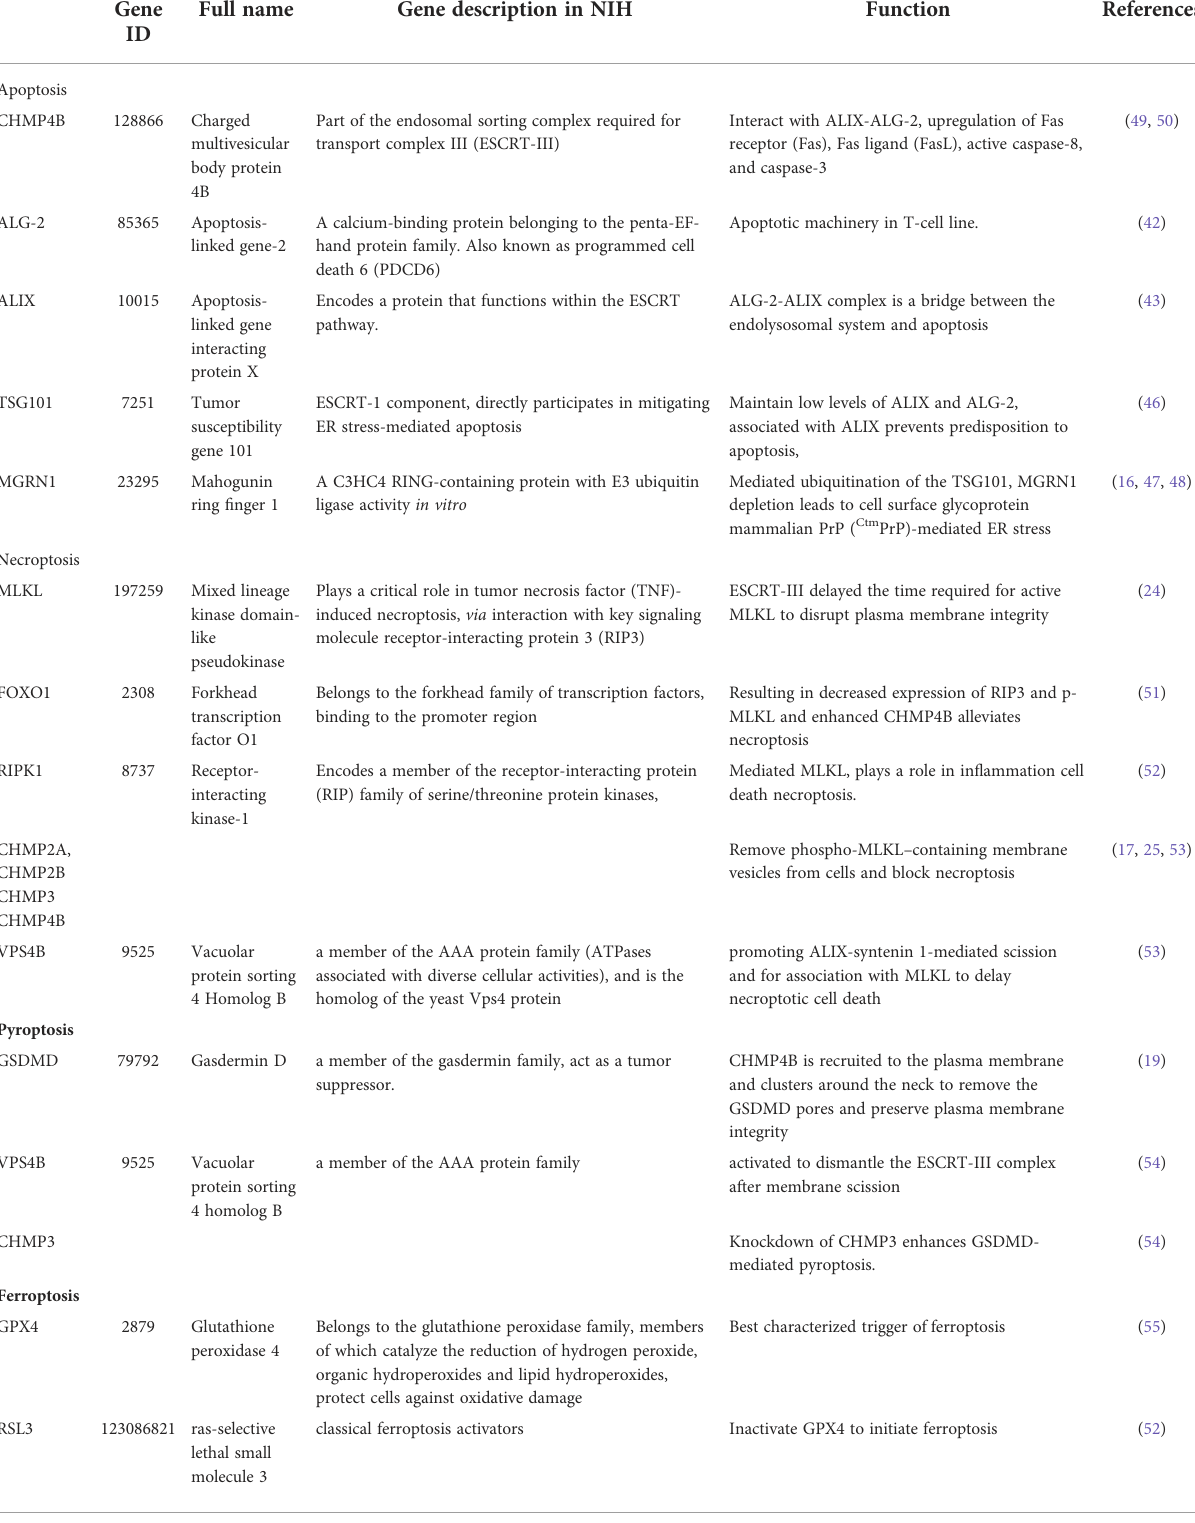
TABLE 1 The endosomal sorting complex required for transport (ESCRT) machinery plays a key role in the repair of damaged plasma membranes in regulated cell death, apoptosis, necroptosis, pyroptosis, ferroptosis, and autophagy.